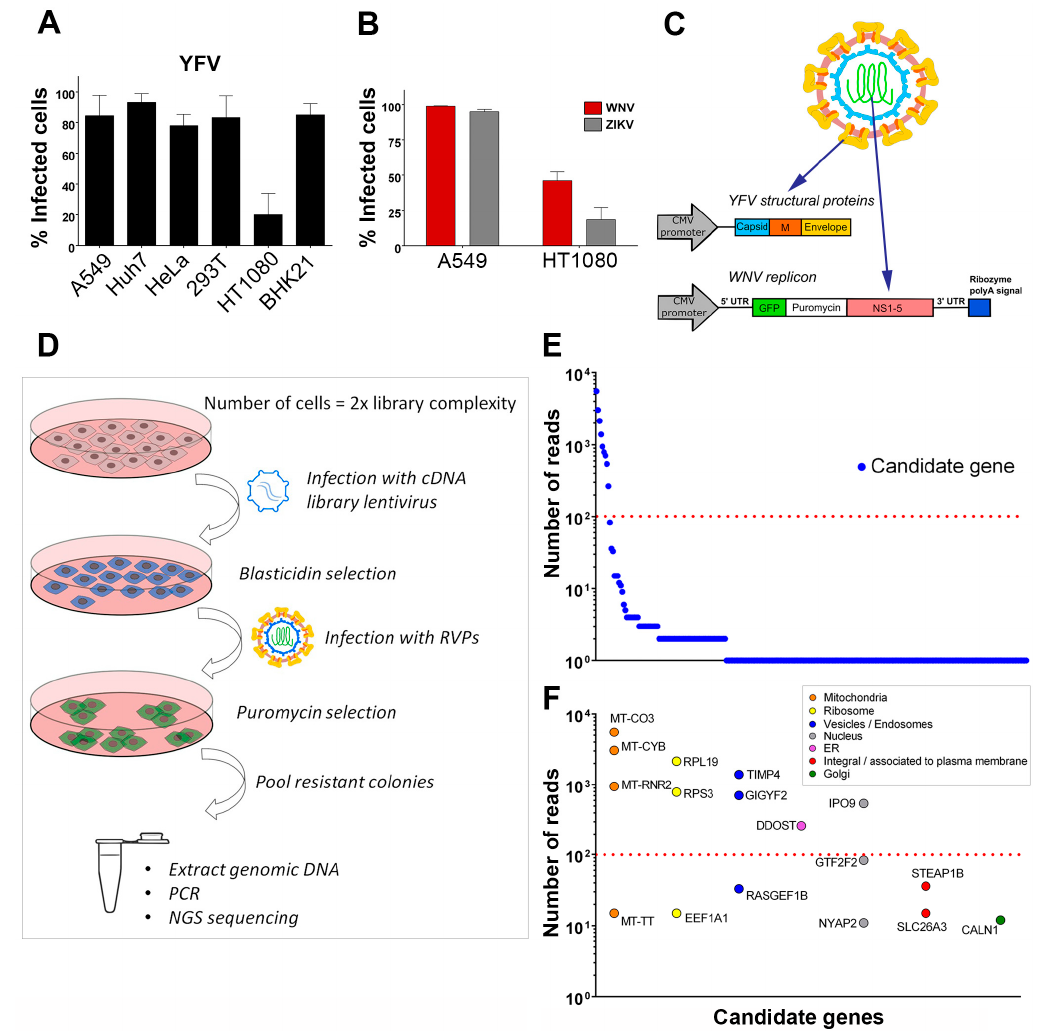
Figure 1. Identification of host factors that promote the replication of chimeric yellow fever (YFV)/ West Nile (WNV) reporter particles. (A) A panel of mammalian cell lines was infected with YFV at a multiplicity of infection (MOI) of 1 for 24 h. The percentages of cells that expressed the viral E protein were determined by flow cytometry analysis. (B) A549 and HT1080 cells were infected with WNV or Zika (ZIKV) at an MOI of 1. The percentages of cells that expressed the viral E protein were determined by flow cytometry analysis 24 h post-infection. (C) Schematic depiction of YFV/WNV chimeric reporter viral particles (RVPs). (D) Schematic depiction of the genome-wide gain-of-function cDNA screening approach. (E) Candidate genes identified by next-generation sequencing of pooled-colony genomic DNA. The Y-axis represents the number of reads that map to each gene, represented by a circle. (F) The genes with more than ten reads were classified according to subcellular localization. The Y-axis represents the number of reads that map to each gene. Data in (A) and (B) are represented as mean ± SD of at least three independent experiments. The red line in (E) and (F) marks a cut-off value of 100 reads per mapped gene.